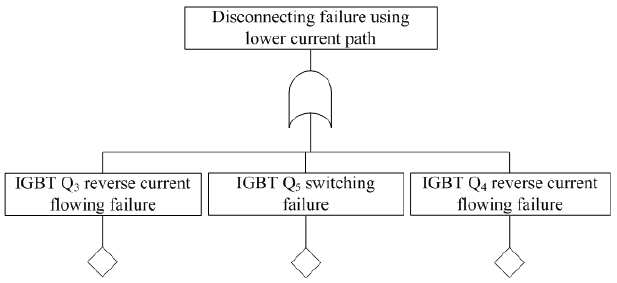
Figure 14. Sub fault tree for disconnecting failure using upper current path.